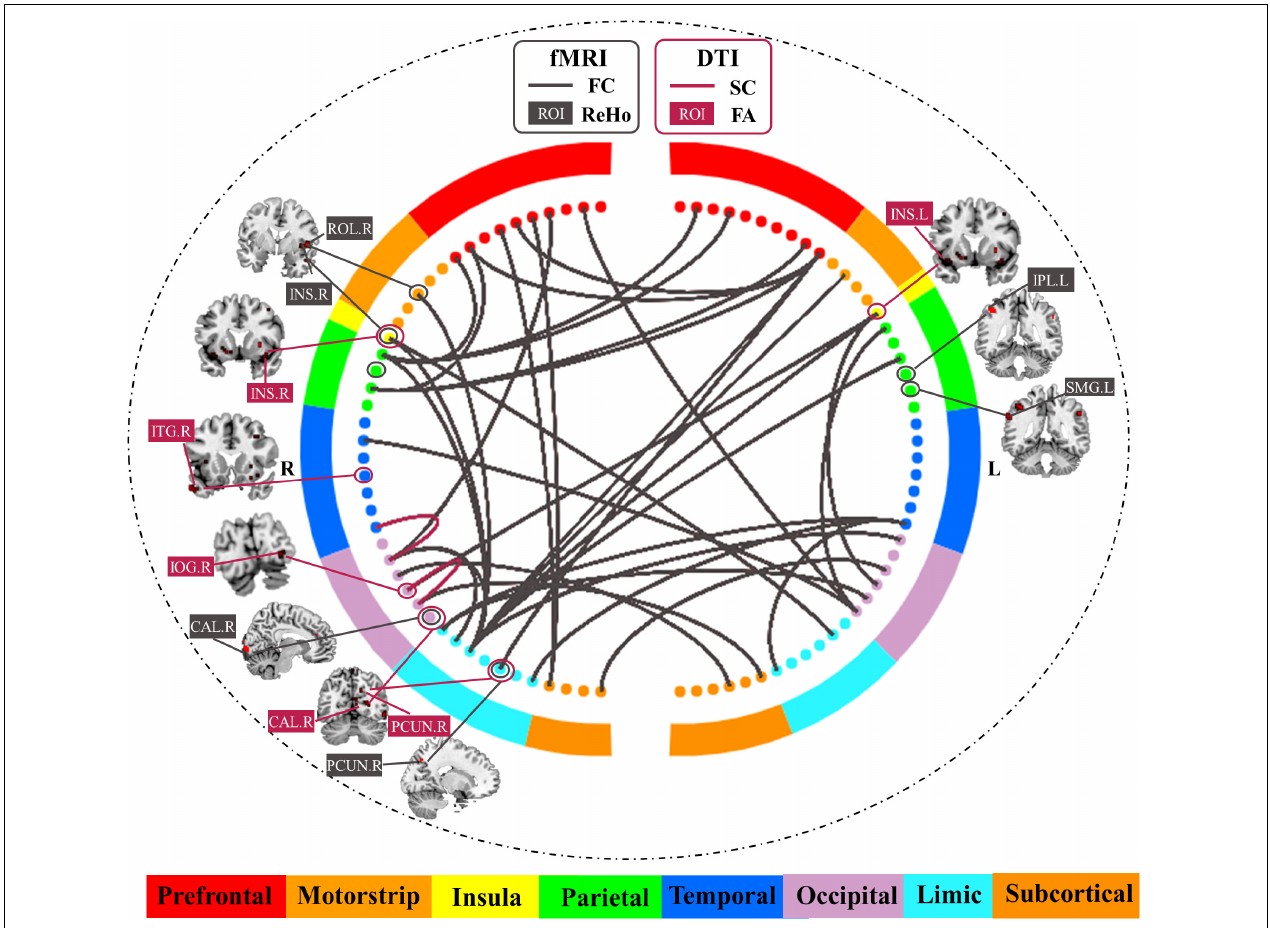
FIGURE 4 | Common predictive regional features and connectivity features for the prediction of laser pain